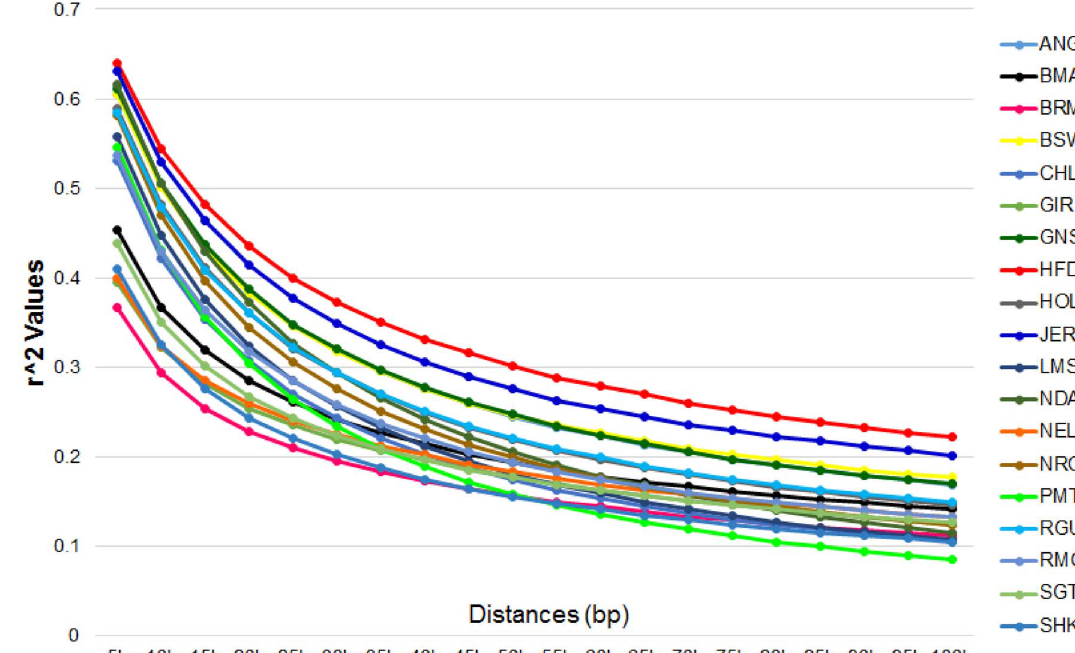
Figure 2. Linkage Disequilibrium. - Genome-wide LD decay in all breeds.